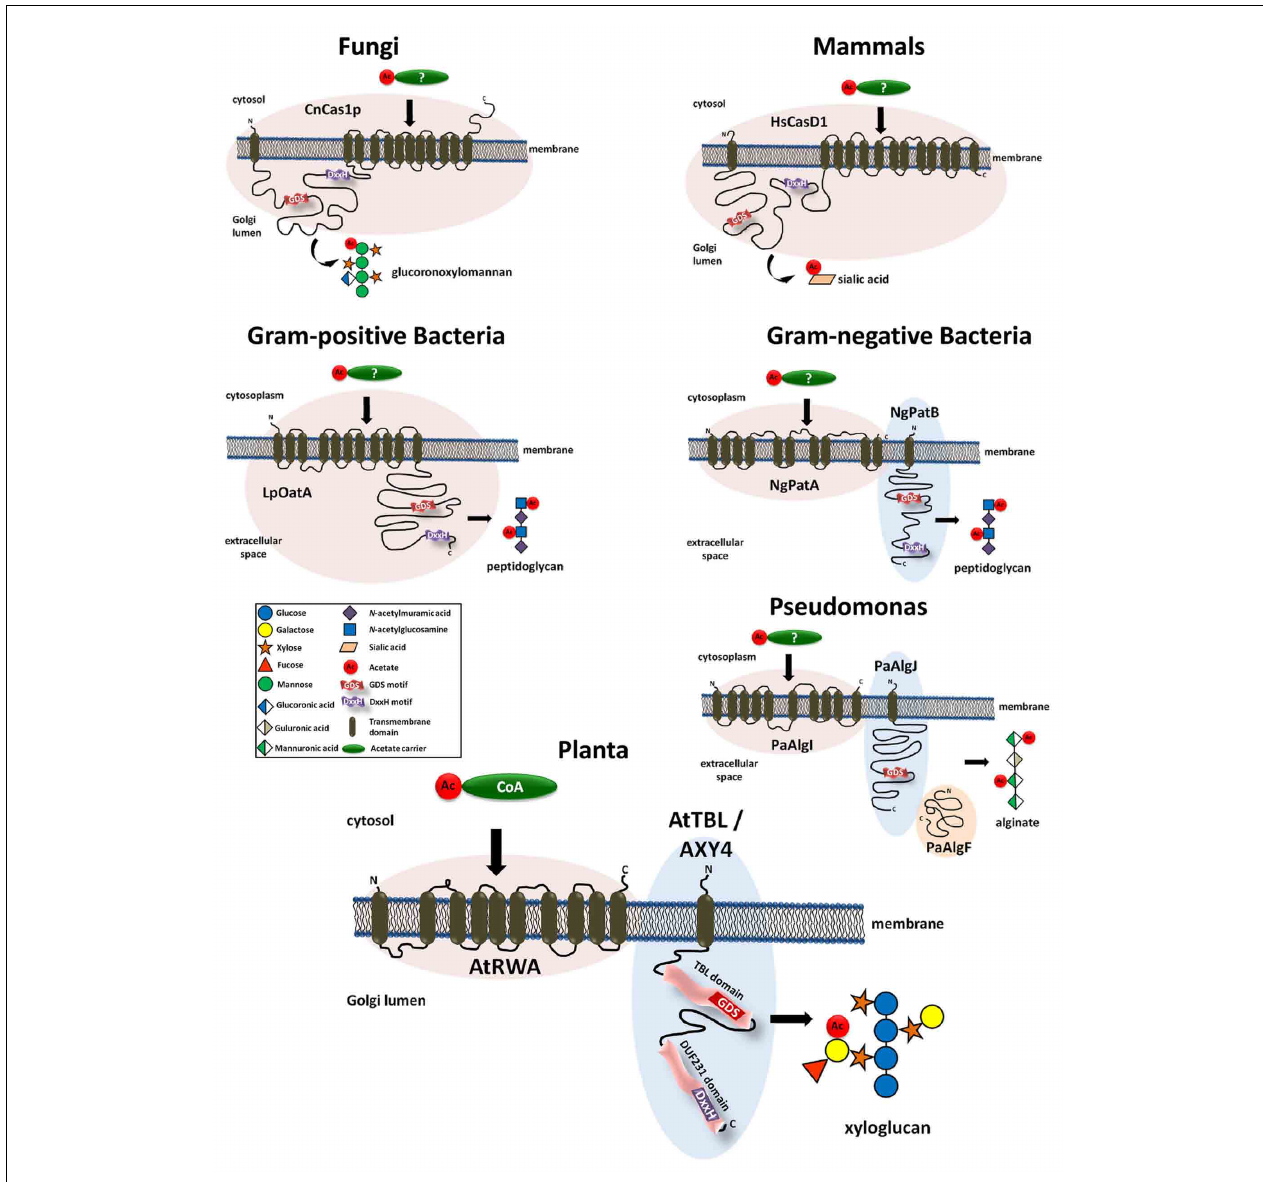
domain, proposed to be involved in the translocation of an acetyl-carrier across a membrane. In addition, they contain a large globular domain with highly conserved GDS and DxxH peptide motifs (see also Figure 2 ) representing the presumed acetyltransferase.While in fungi, mammals, and Gram-positive bacteria this mechanism is realized in a single protein, in Gram-negative bacteria and plants this mechanism is split into two proteins. Alginate O -acetylation in Pseudomonas seems to be a special case as no DxxH motif can be found and three proteins were shown to be